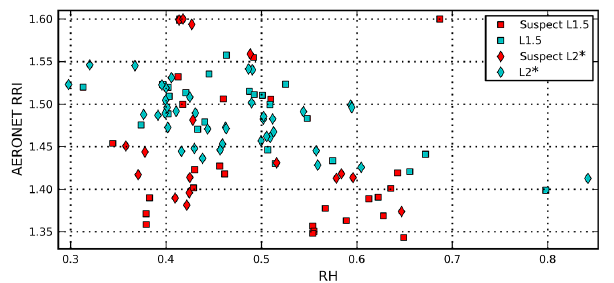
Figure 4. Scatterplot of the column effective relative humidity (RH) and the AERONET real refractive index (RRI) for level 1.5 data (squares) and L2 ∗ data (diamonds). The AERONET data that have been labeled “suspect” are presented in red.